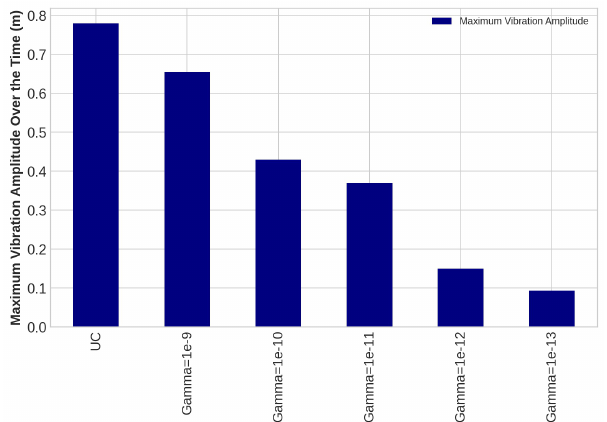
Figure 11. The outcomes of applying controlling rule for the thirtieth sensor under loading number 2 (30-degree attack angle).